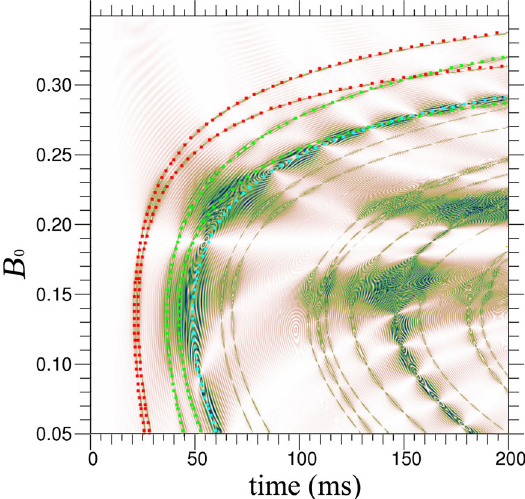
FIG. 6. Decoherence for an interacting cluster of three spins (3-cluster). The colored lines show comparisons with Eq. (10), showing excellent agreement with numerics obtained by diago- nalization of the full joint sensor-cluster